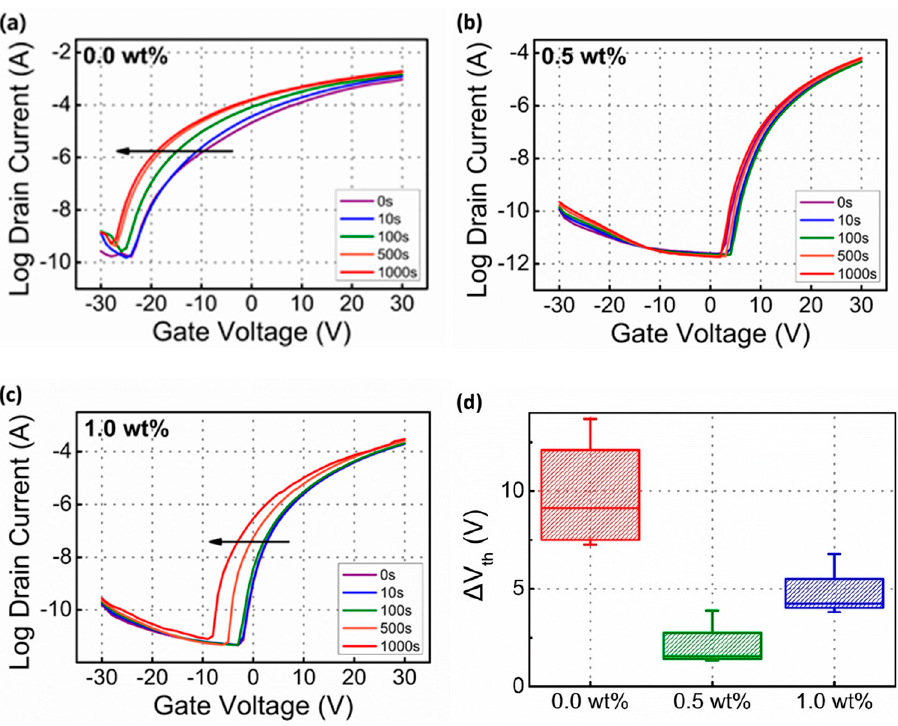
Figure 5. ( a – c ) Variation in transfer curves and ( d ) change in V th of Li-doped SnO 2 based TFTs during NBS test.